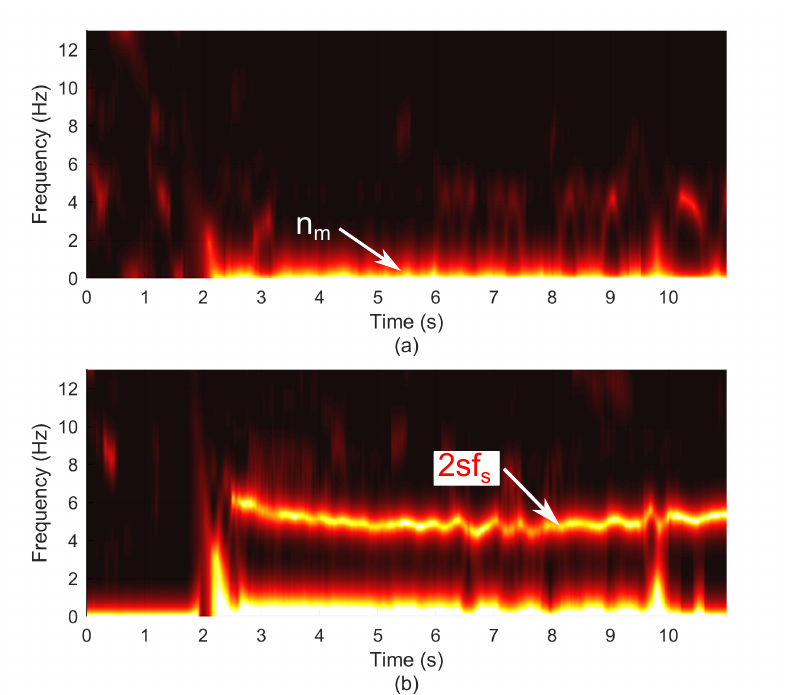
Figure 9. Time-frequency analyses of the motor speed under startup transient and high-load level for: ( a ) healthy motor and ( b ) rotor with one full broken rotor